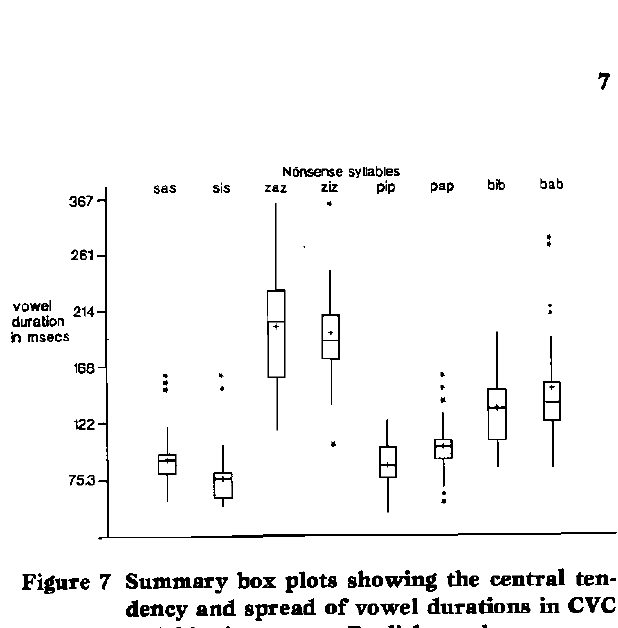
Figure 7 Summary box plots showing the central ten- dency and spread of vowel durations in CVC syllables in younger English